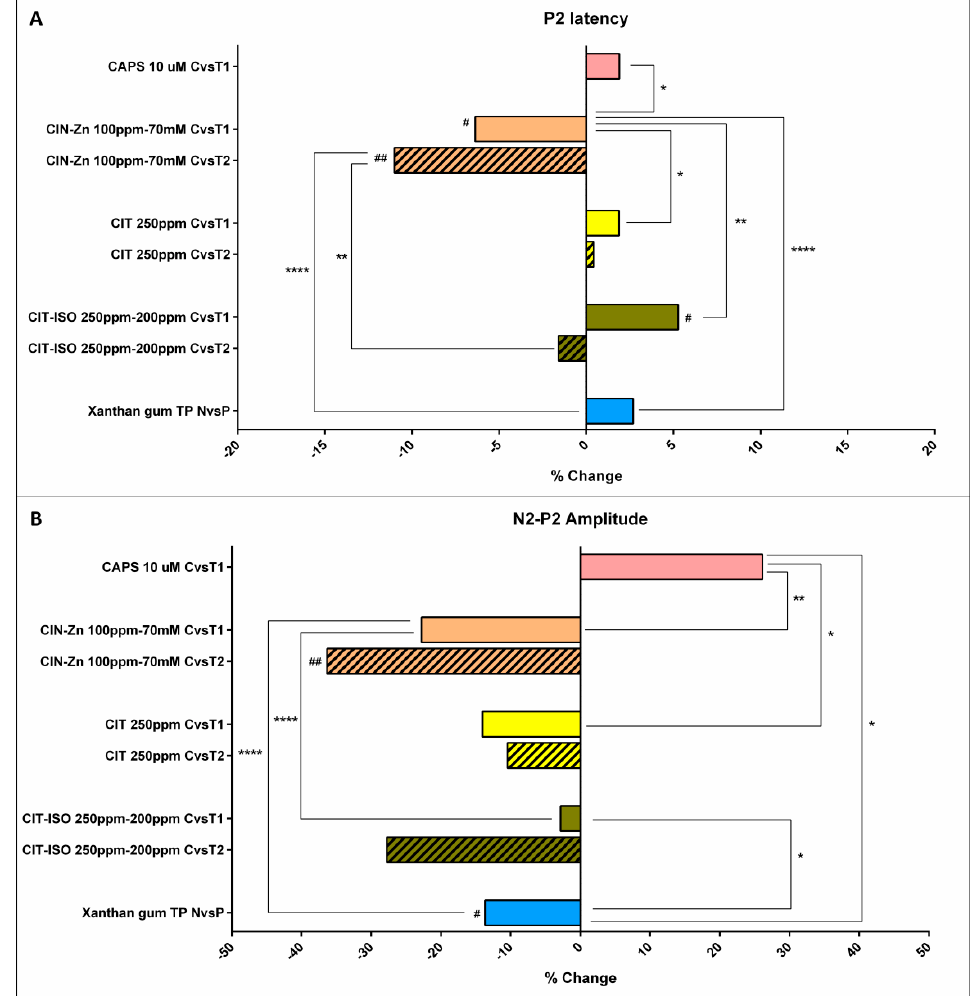
Figure 3. Normalized effect of compensatory and active treatments on the latency of P2 peak ( A ) and N2-P2 amplitude ( B ). CAPS: capsaicin; CIN-Zn: cinnamaldehyde-zinc; CIT: citral; CIT-ISO: citral-isopulegol; C: control nectar; T1: supplemented nectar 1; T2: supplemented nectar 2; N: nectar; P: pudding; TP: thickening product; #: p < 0.05; ##: p < 0.01 compared to its own control; *: p < 0.05; **: p < 0.01; ****: p < 0.0001 compared to the other